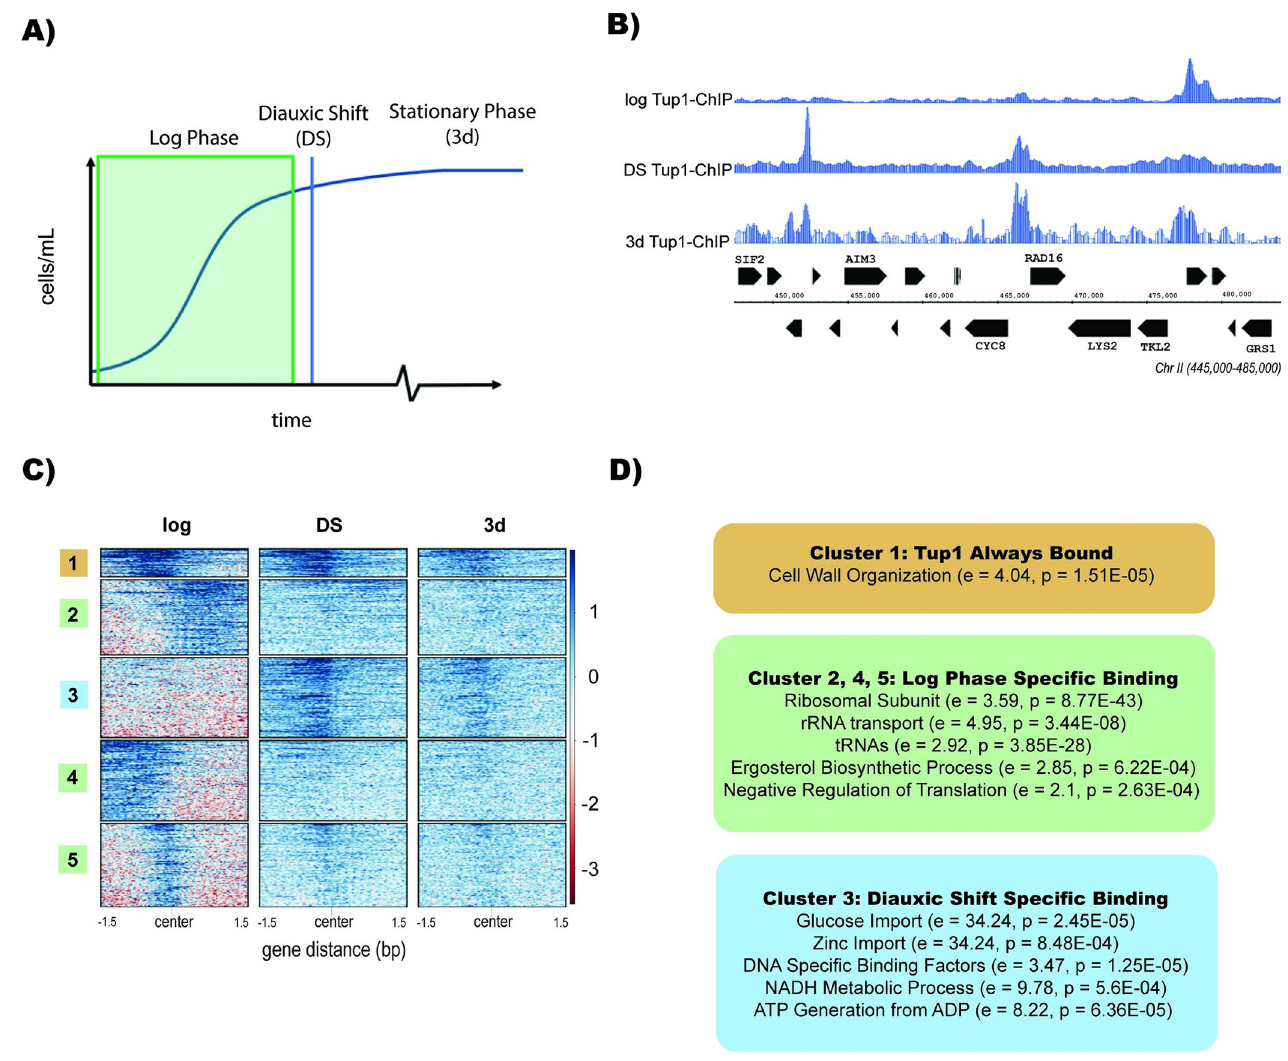
Fig 1. Tup1 Relocalizes After Glucose Starvation. (A) Illustration of a yeast growth curve indicating diauxic shift (DS) and stationary phase (3d). (B) Integrated Genome Browser (IGB) tracks representative of Tup1-myc ChIP-Seq during log phase, diauxic shift, and stationary phase. Data are normalized to RPKM. (C) ChIP-Seq heatmap of Tup1 binding during log phase, diauxic shift, and stationary phase. Heatmap was clustered using deeptools and sorted by binding intensity. (D) Gene ontology analysis from GOrilla of Tup1 binding locations with relative enrichment (e) and p-value (p) indicated for each term.